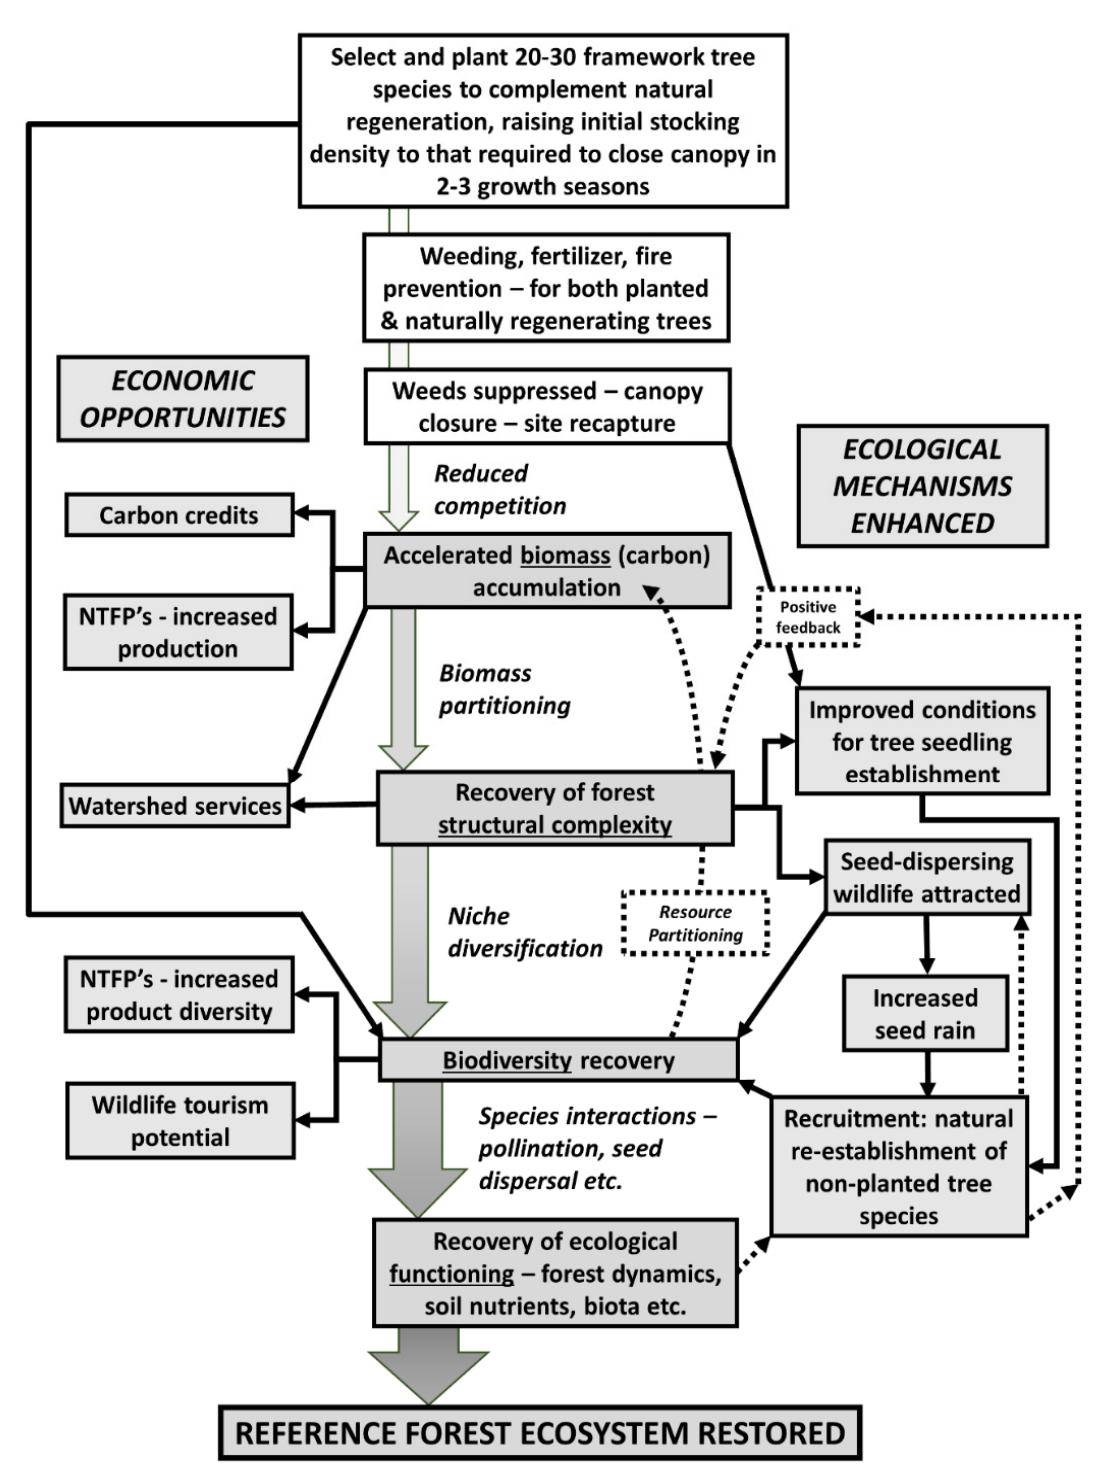
Figure 1. How the framework species method works. Wide grey arrows indicate progress of restoration; narrow black arrows indicate “origin affects destination”, whilst dotted lines indicate positive feedback.